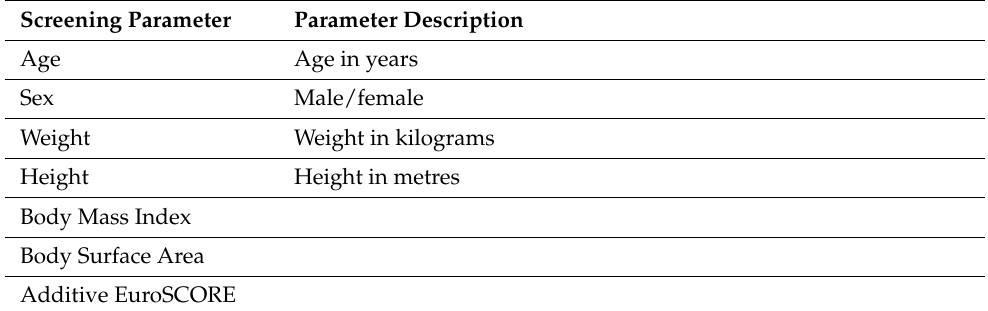
Table 1. Acquired baseline